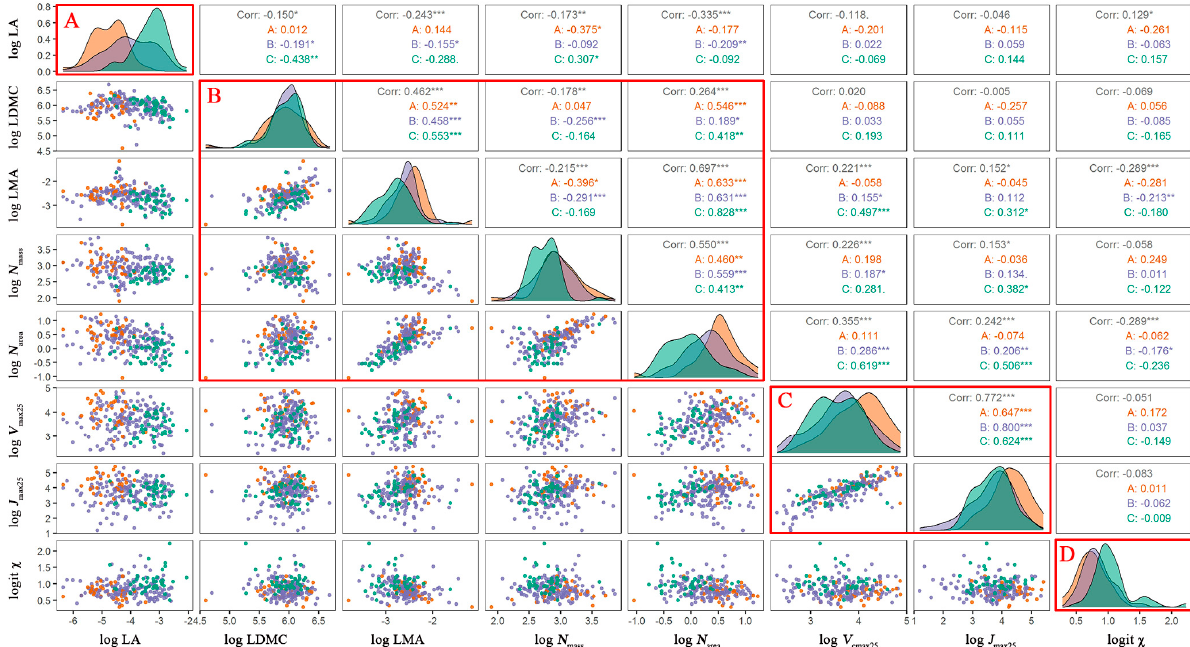
Figure 3. Correlations among eight plant functional traits. ( A – D ) Four trait dimensions of eight traits. LA: leaf area; N mass : leaf nitrogen content per mass; N area : leaf nitrogen per area; LMA: leaf mass per area; LDMC: leaf dry mass content; V cmax25 : maximum carboxylation rate standardized to 25 ◦ C; J max25 : maximum electron transport rate standardized to 25 ◦ C; χ : ratio of intercellular to ambient CO 2 concentration. “*” indicates p < 0.05. “**” indicates p < 0.01. “***” indicates p < 0.001.